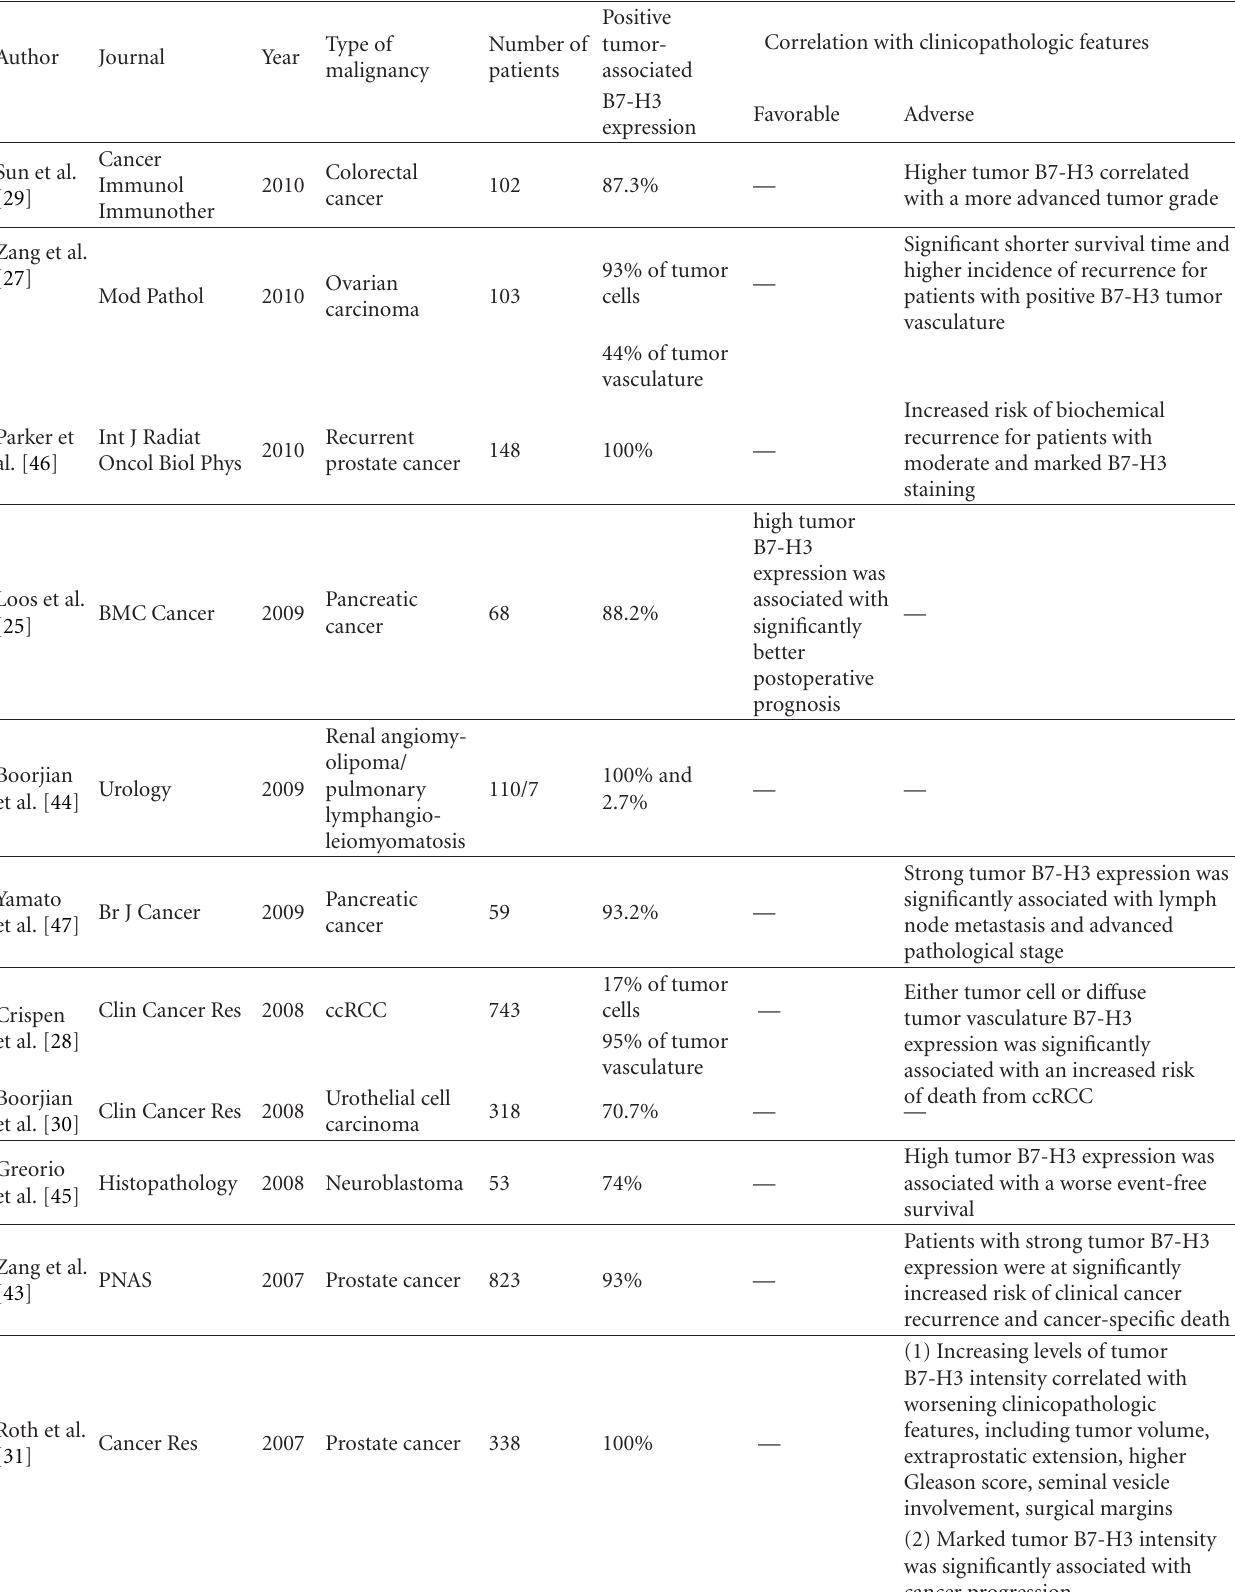
Table 1: Relevant clinical studies investigating the relationship between B7-H3 expression in human cancer tissues with clinicopathological